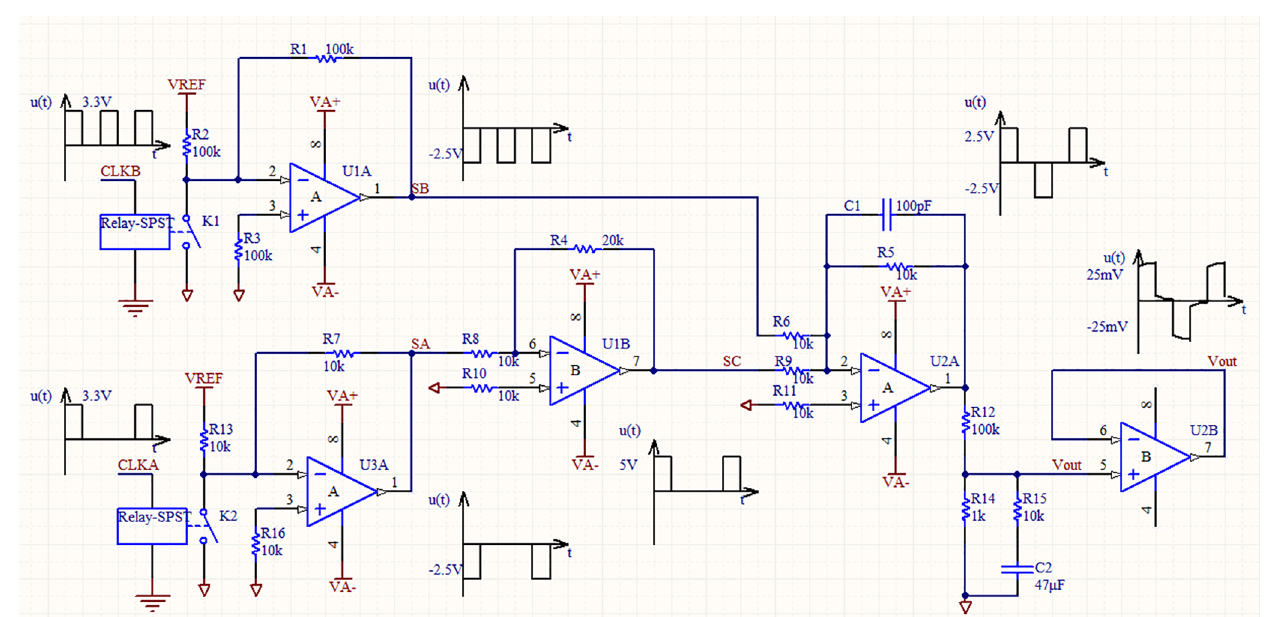
Figure 8. Schematic of the shaper circuit.